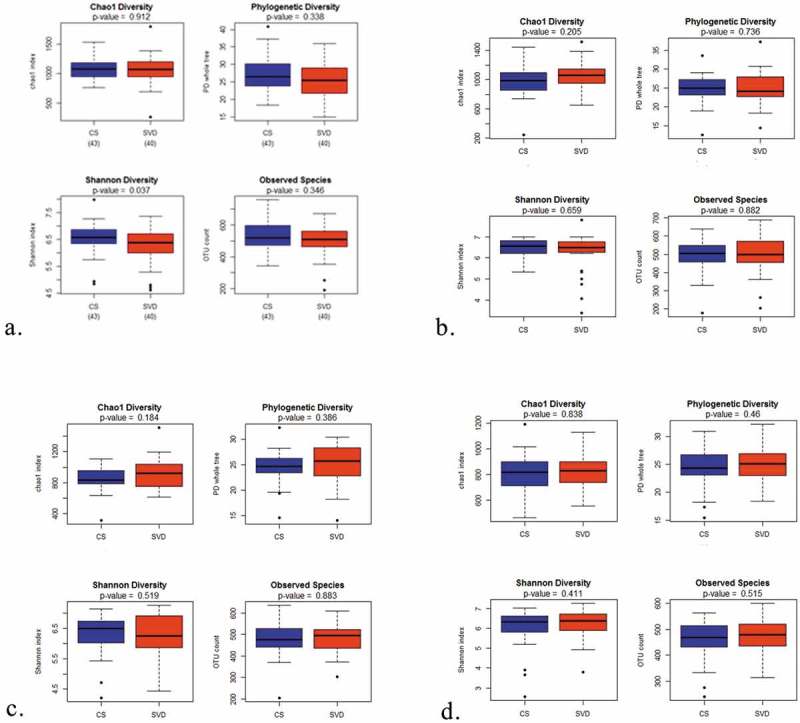
Alpha-diversity measurement of the influence of mode of delivery (SVD vs. CS) on the infant oral microbiota at various time points (week 1, week 4, 6 months and 1 year). Boxplot of the chao1 diversity, observed species, phylogenetic diversity and Shannon diversity in the two groups (SVD and CS) at (a) week 1, (b) week 4, (c) 6 months and (d) 1 year. Outliers are represented by black points.